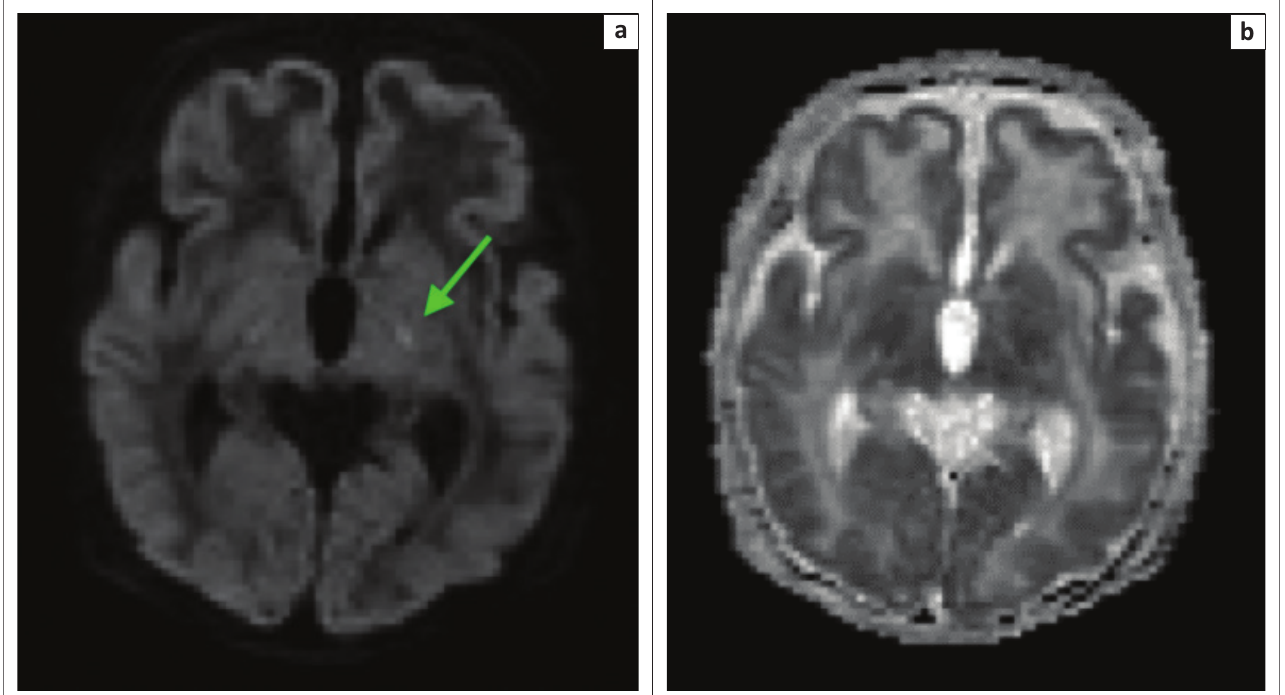
FIGURE 5: The same child as in Figure 4. (a) The B1000 sequence and (b) the apparent diffusion coefficient (ADC) map obtained after 1 week demonstrating pseudonormalisation phenomenon with trace remaining hyperintensity at the ventral thalamus (green arrow) and no associated ADC shortening.